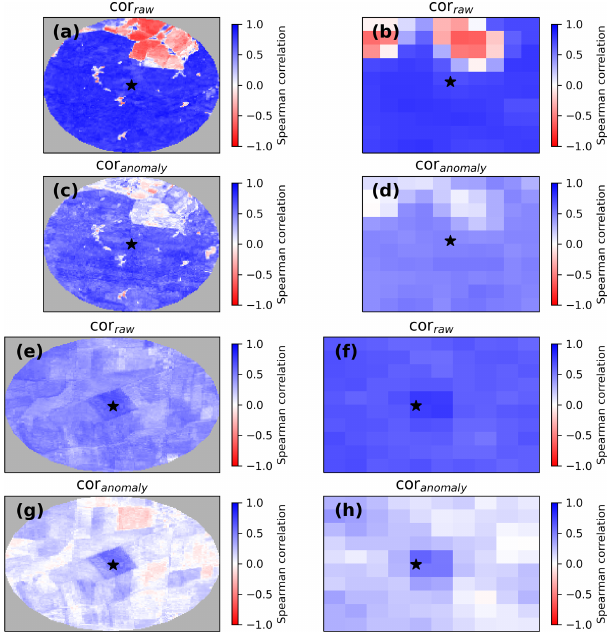
Figure D1. Spearman correlation between EVI and GPP using monthly Landsat (a, c, e, g) and daily MODIS (b, d, f, h) data for ES-LM1 (a–d) and DE-Geb (e–h) Fluxnet sites. The correlation es- timates were computed on the raw time series (a, b, e, f) and on the anomalies (c, d, g, h)